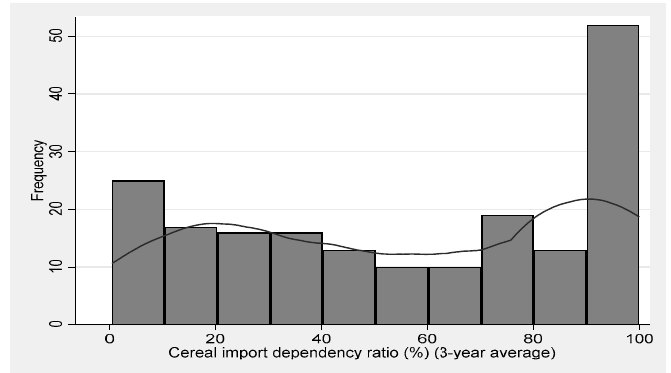
Figure 1. The figure shows the frequency distribution and kernel density of the cereal import dependency ratio (CIDR) for water-scarce countries for the full sample.